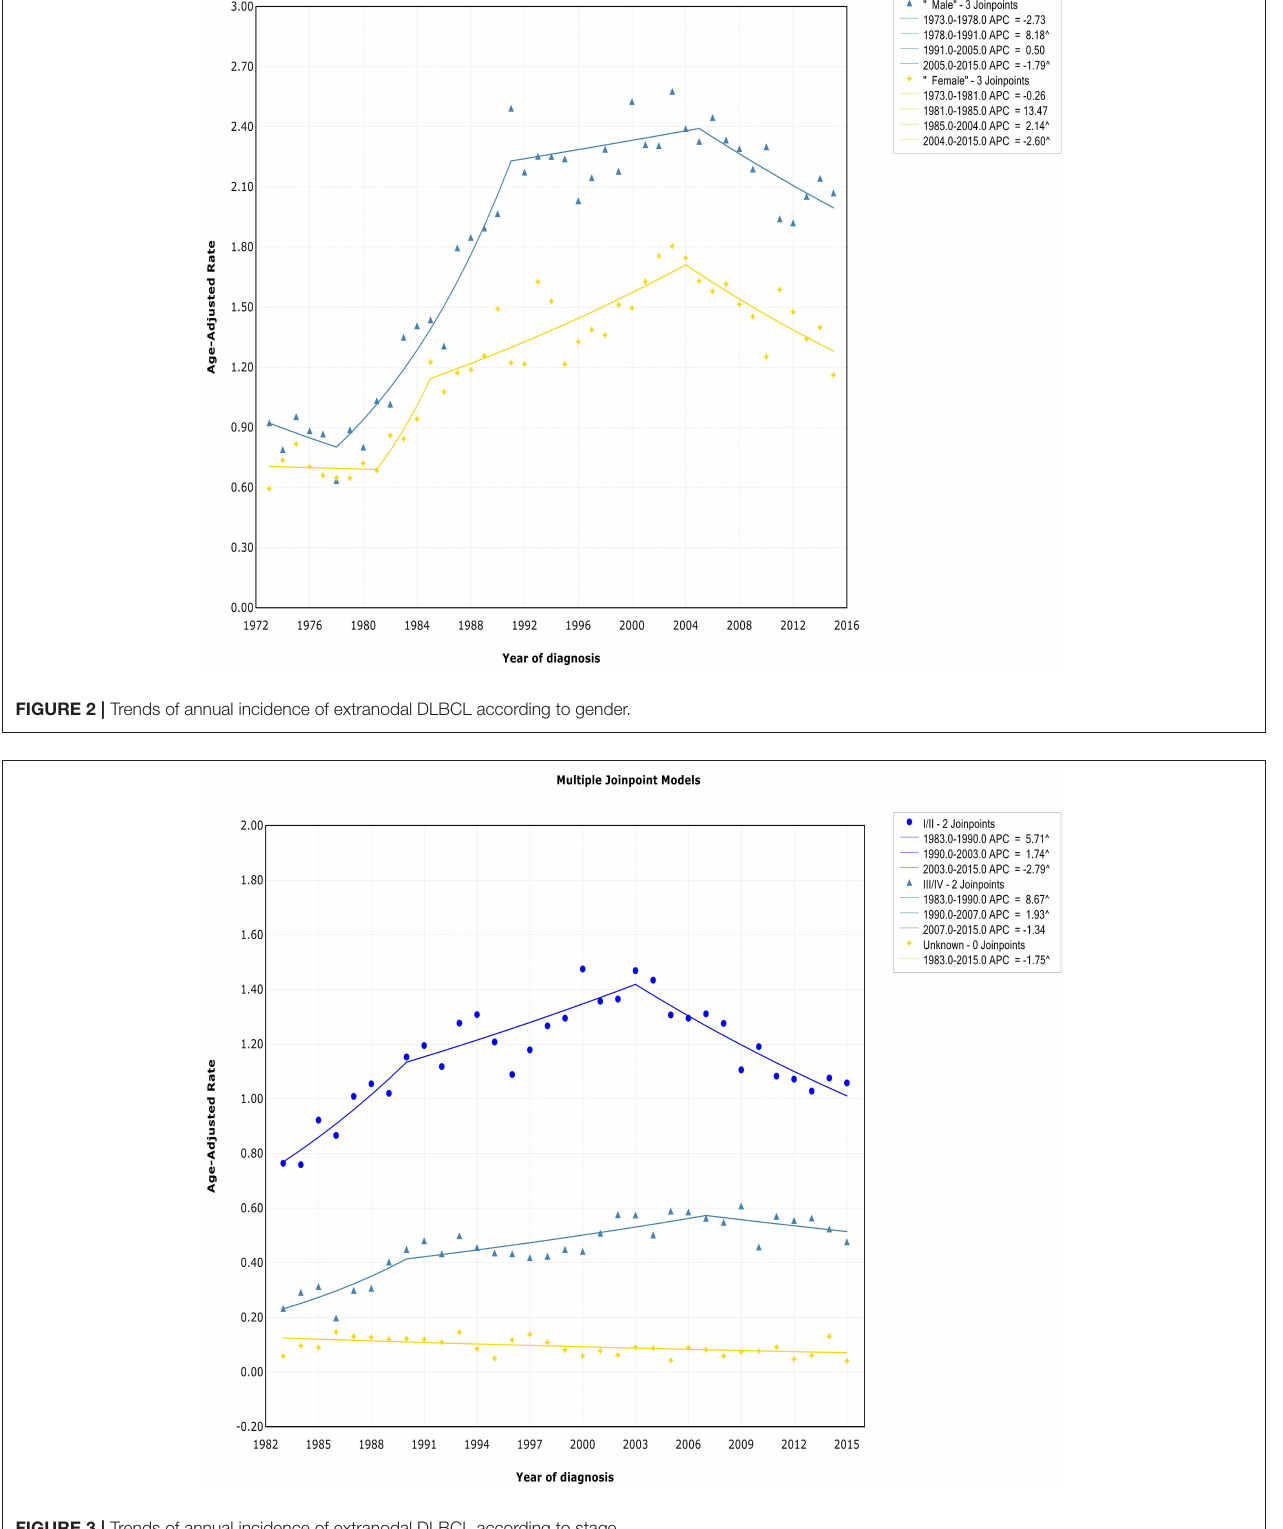
Frontiers in Oncology |